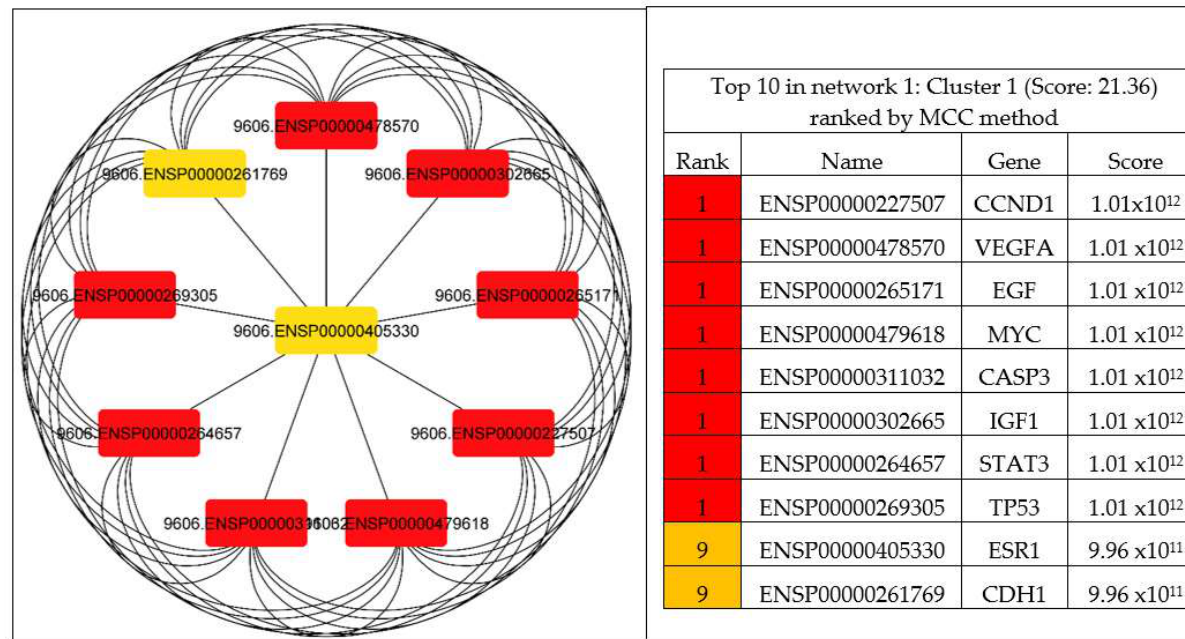
Figure 6. Identified hub genes by CytoHubba among the 81 overlapping genes. The top eleven nodes are shown with a color scheme from red (highly important) to orange (important), and the top eleven genes in the PPI network were calculated by MCC.